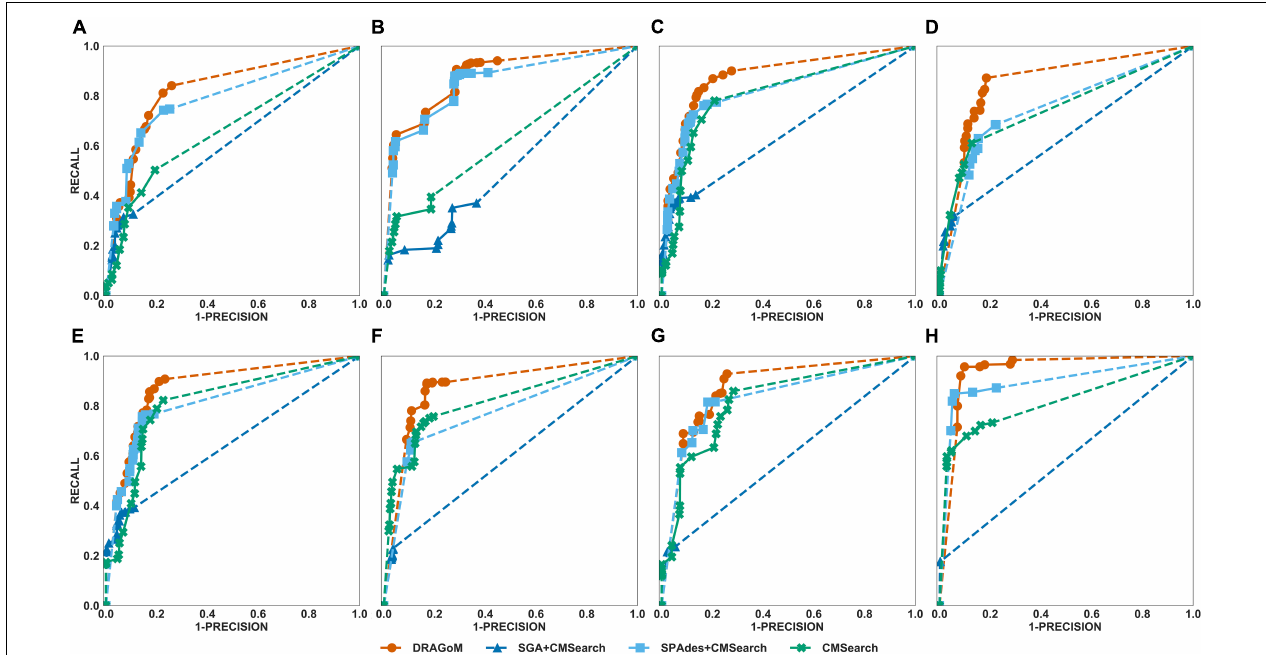
FIGURE 6 | The ROC curves for searching (A) 29 ncRNA families with a sequence identity of less than 50% and sequence length from 100 to 200nt, (B) eightnc RNA families with a sequence identity of less than 50% and sequence length from 200 to 400nt, (C) 78 ncRNA families with a sequence identity from 50 to 70% and sequence length from 100 to 200nt, (D) 19 ncRNA families with a sequence identity from 50 to 70% and sequence length from 200 to 400nt, (E) 86 ncRNA families with a sequence identity from 70 to 90% and sequence length from 100 to 200nt, (F) 19 ncRNA families with a sequence identity from 70 to 90% and sequence length from 200 to 400nt, (G) 25 ncRNA families with a sequence identity of more than 90% and sequence length from 100 to 200nt, and (H) 12 ncRNA families with a sequence identity of more than 90% and sequence length from 200 to 400nt using the corresponding programs against DS5 (the subsampled CAMI